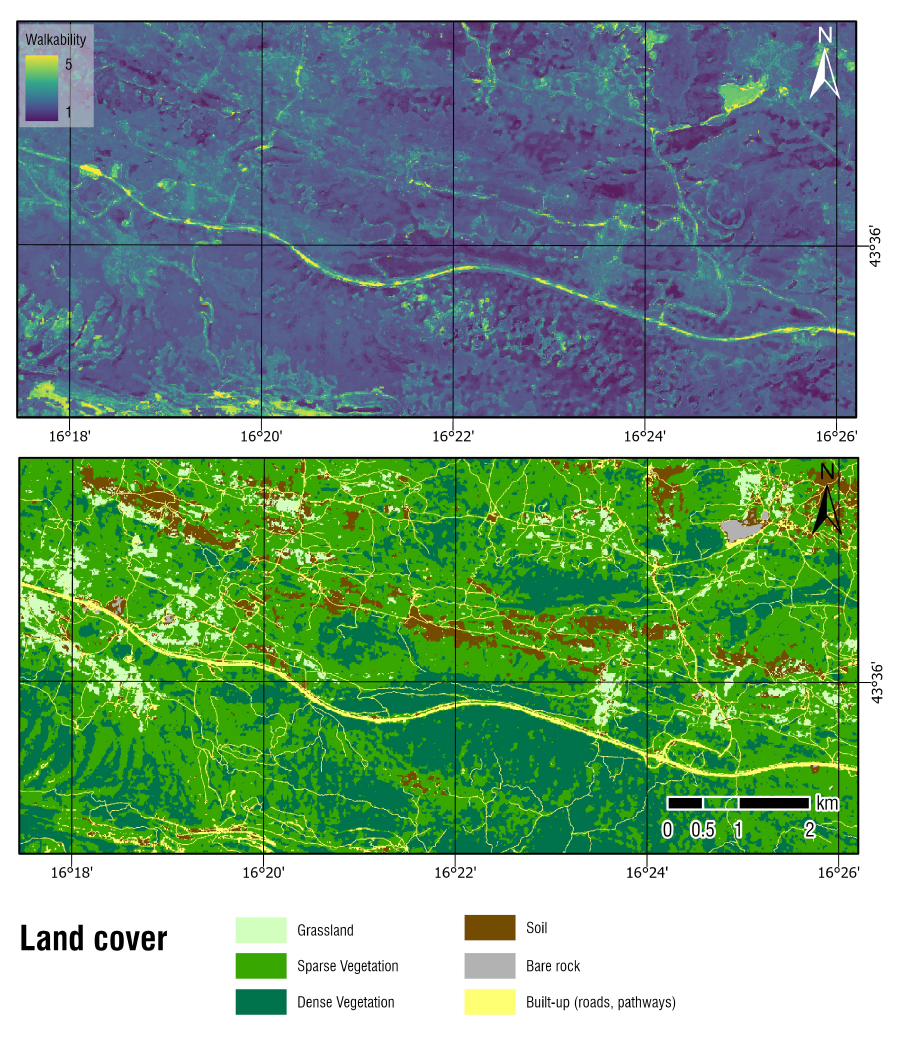
Figure 7: Walkability map for the Kozjak Mountains study area predicted by our model (top image). The thin gray lines represent the 25-meter elevation contours. Land cover map from Sentinel-2 and OpenStreetMap data (lower